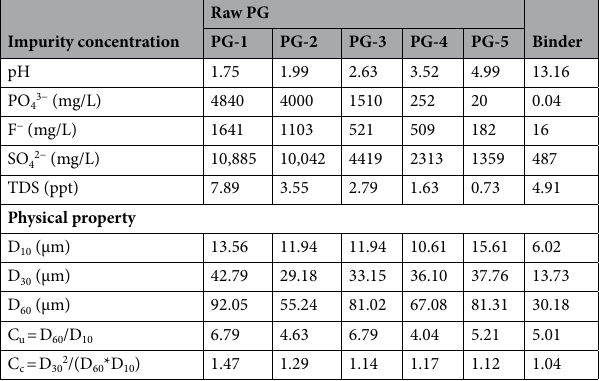
Table 1. Impurity concentrations and physical properties of PG and